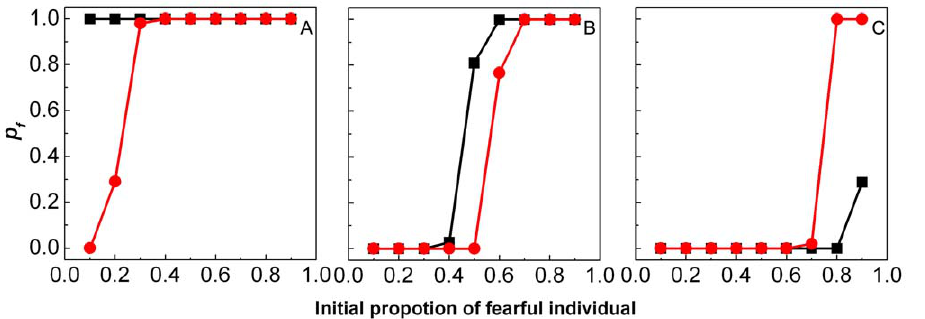
Figure 1. The effect of population size on the evolution of fearfulness and boldness. The population sizes are taken as N total ~ 80 (A), N total ~ 240 (B), and N total ~ 400 (C), respectively. p f denotes the frequency that R f -population occurs, i.e. p f ~ C f = 1000 . Simulations are conducted for both frequency-dependent (black line) and frequency-independent (red line) risk sharing situations.